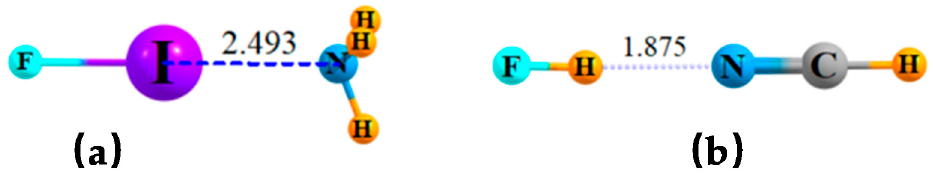
Figure 1. Optimized geometries of ( a ) FI ··· NH 3 and ( b ) FH ·· NCH dyads. Distances in Å.